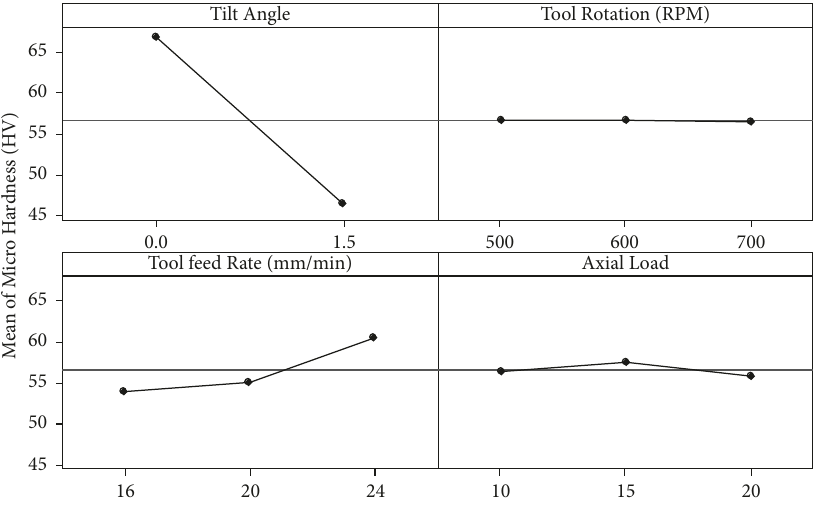
Figure 3: Main effect plot for microhardness of FSW